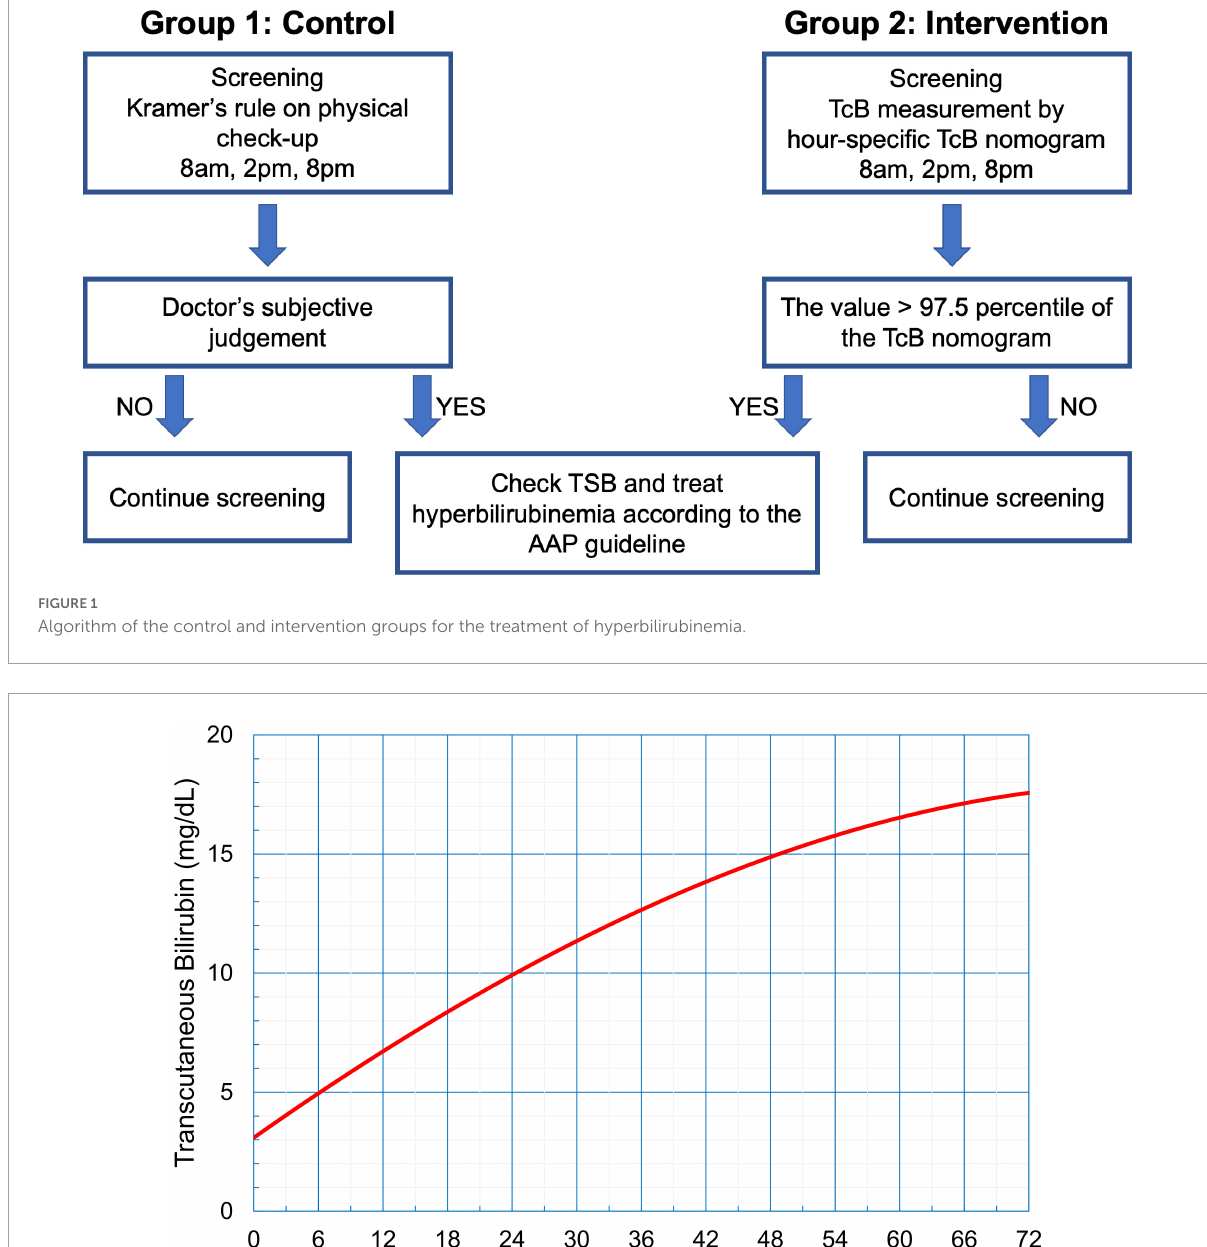
nomogram). Baseline data were retrieved from the annual reports of the Central Women’s Hospital Yangon for the years 2016 (16) and 2019 (17). Data on the date of